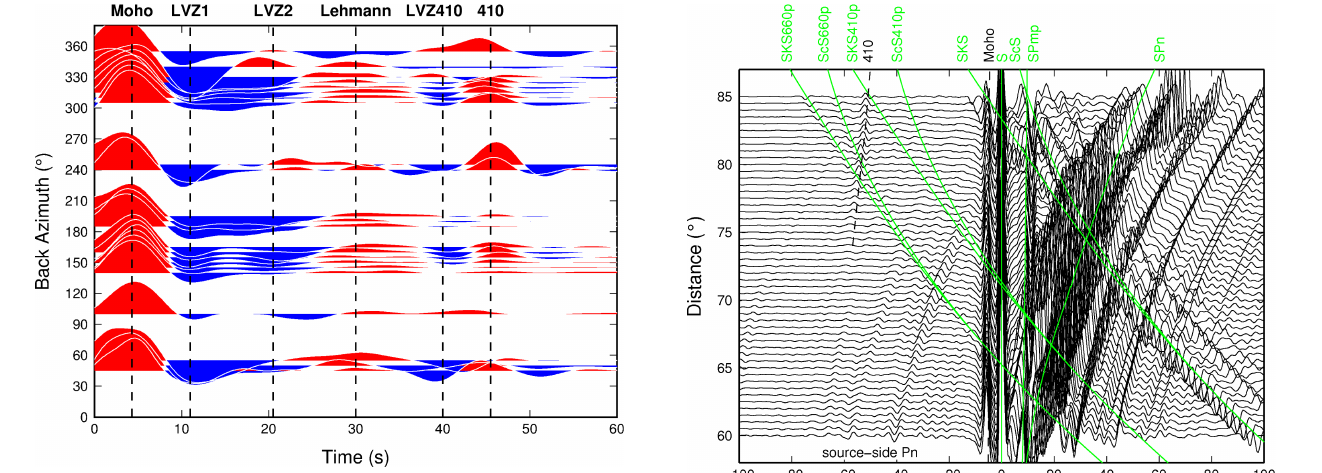
Figure 5. Display of binned S-receiver functions as a function of the back azimuth (see Fig. 2) of the source of each record, inde- pendent of epicentral distance. Only stations on the cratonic part of the United States (east of 110 ◦ W) are used. The same phases as in Fig. 4 are marked. Most phases do not show any clear dependence on the back azimuth. The only exception might be the 410 discon- tinuity, which is strongest for sources in the northwest quadrant.